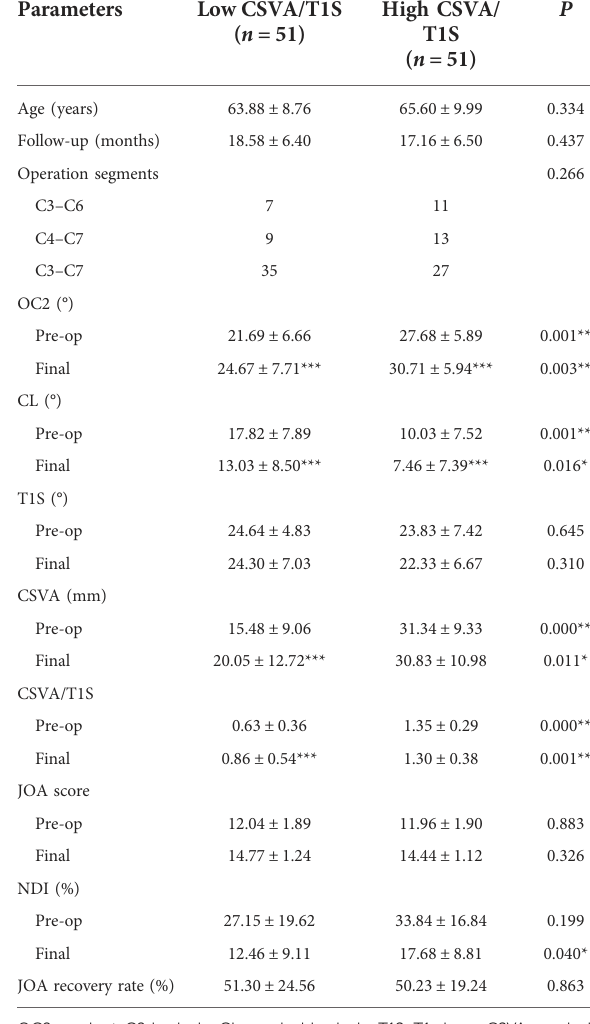
Table 5 summarized the correlations between cervical sagittal parameters and clinical results. Only CSVA/T1S was detected to be correlated with fi nal NDI ( r = 0.310, P = 0.027). No signi fi cant correlation was found between clinical results and T1S, CSVA, or T1S-CL.